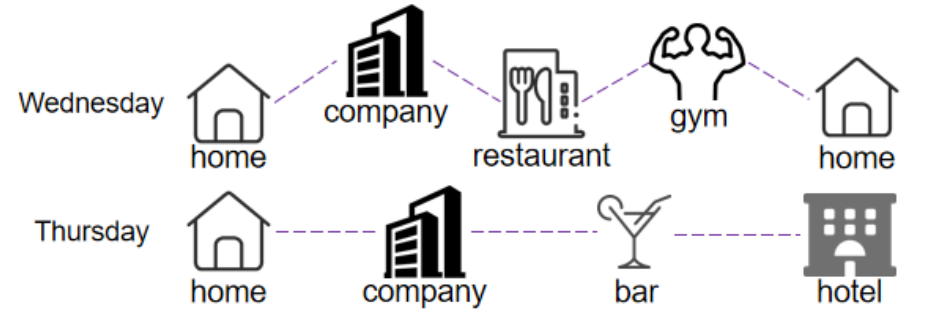
Figure 3. Example of a user check-in pattern on different day of the